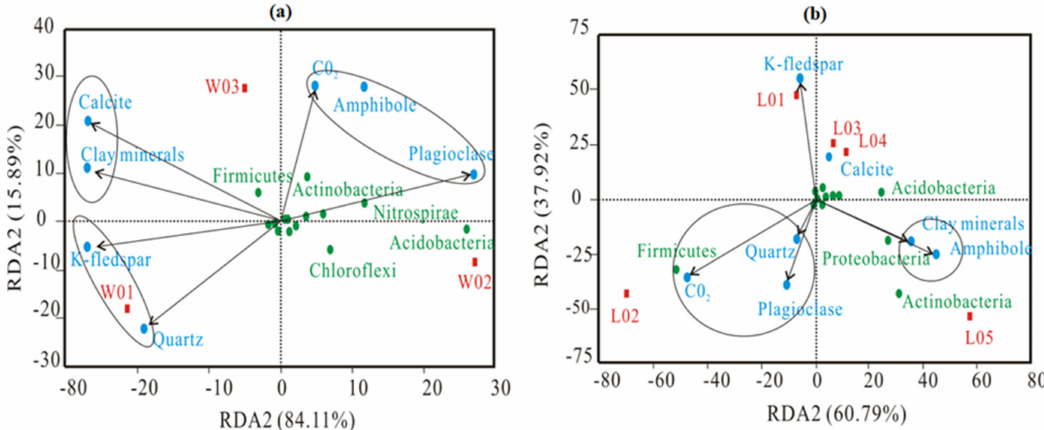
Figure 9. Redundancy analysis (RDA) of the bacterial community species (phylum) in soil and the environmental factors; ( a ) represents the samples from di ff erent depths, and ( b ) represents the samples from di ff erent vegetation types. (The red rectangles are the sample groups under di ff erent environments; the green circles are the bacterial community species (phylum); the blue circles are the environmental factors. The length of the arrow of environmental factors represents the degree of the influence (explanatory quantity) of environmental factors on species data; the angle between the arrows of environmental factors represents a positive and negative correlation (acute angle: positive correlation; obtuse angle: negative correlation; right angle: no correlation); the arrow represents the projection from the sample point to the environmental factors, and the distance from the projection point to the origin represents the distance between the environmental factors and the sample, which represents the relative influence of the community